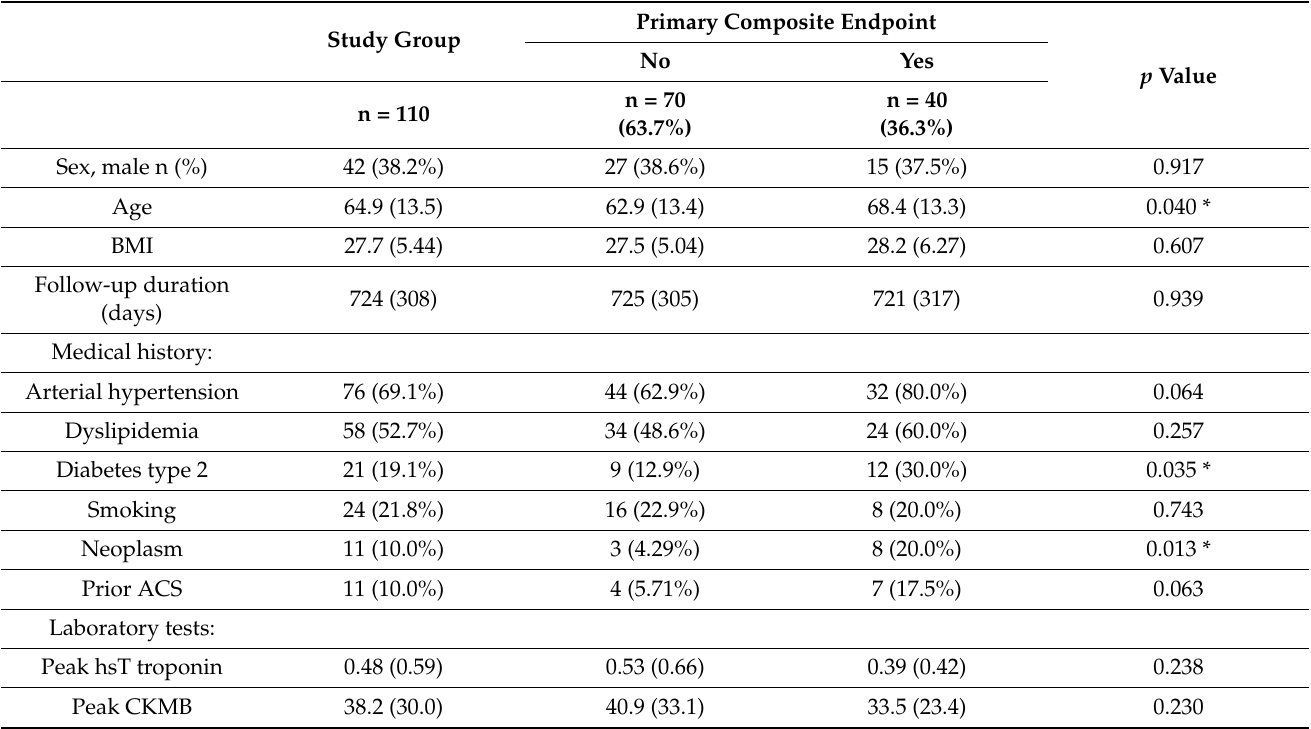
Table 1. Baseline characteristics of the whole study group. Comparison between subgroups divided based on primary composite endpoint occurrence (myocardial infarction, percutaneous coronary intervention, stroke or TIA, all-cause death, re-admission due to cardiovascular